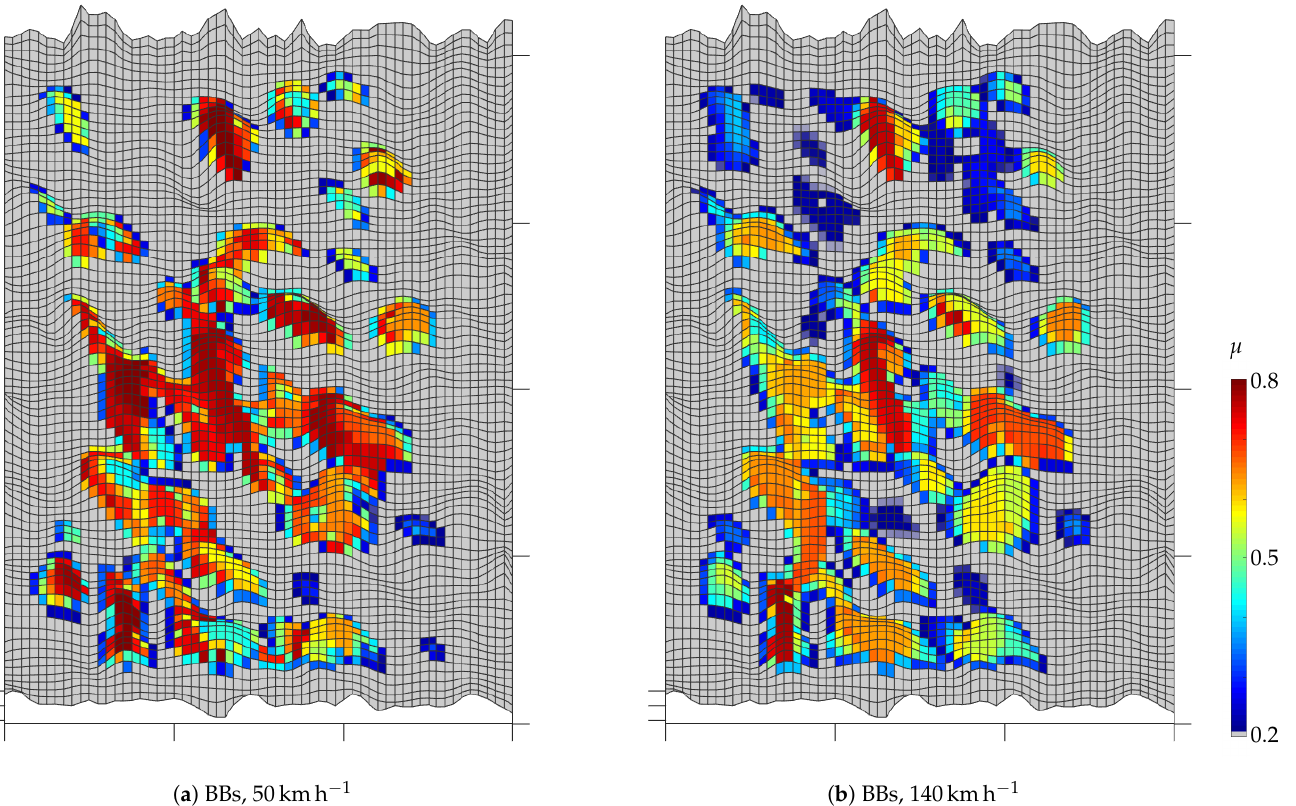
Figure 13. Local friction coefficient on the road surface at the end of the simulation for pattern BBs at 7.5% slip. A 60mm × 80mm large section of the roadway is shown. Direction of travel is from left to